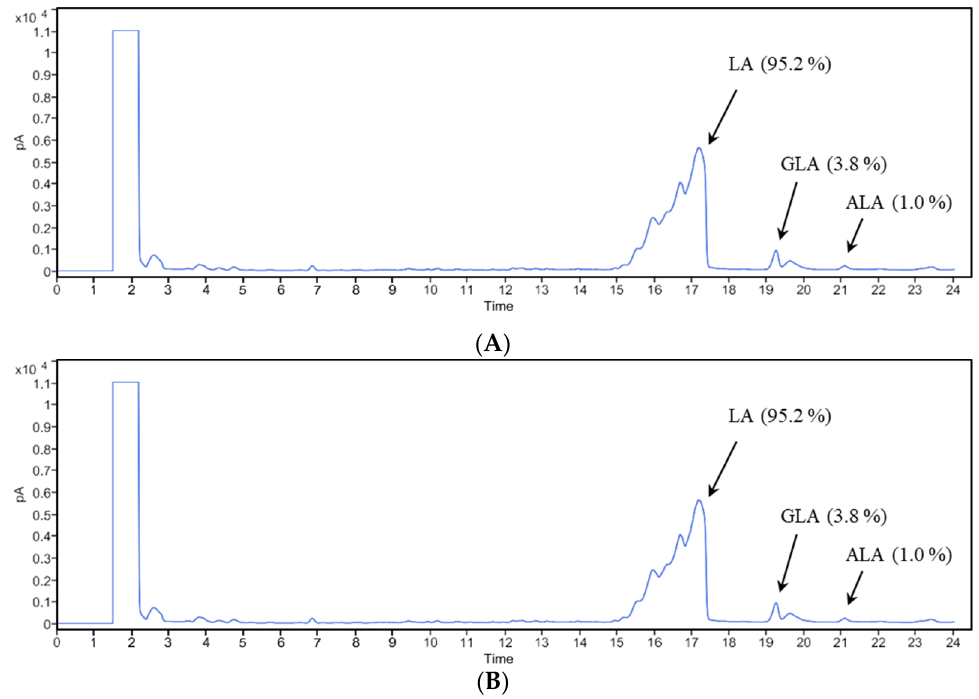
Figure 6. GC chromatogram of fraction C ( A ) and HPLC-grade LA standard ( B ).